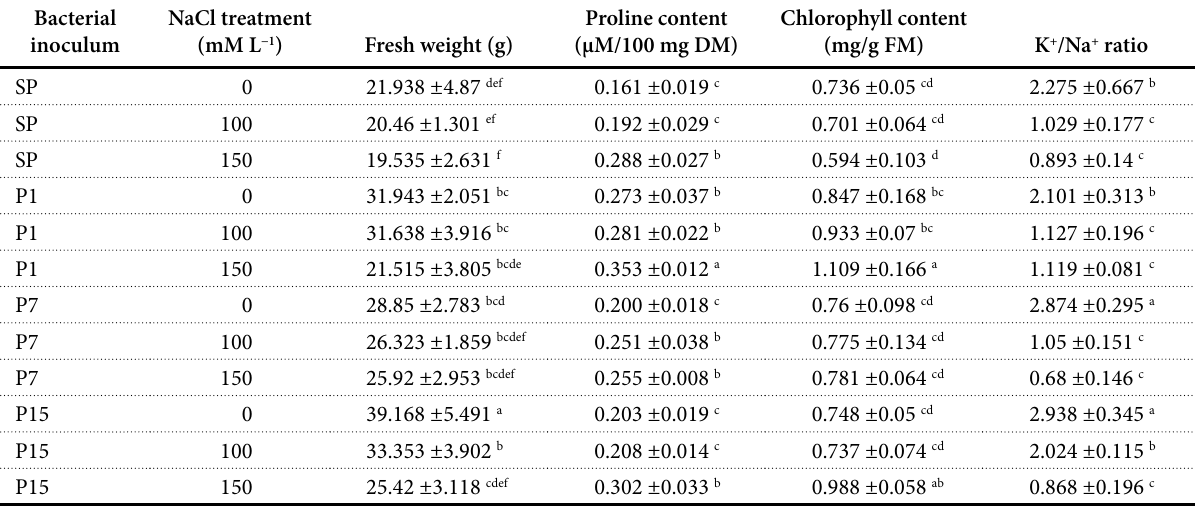
SP – treatment without bacterial inoculation; DM – dry matter; FM – fresh matter. The SP treatment was not inoculated. Results are presented as the mean ± standard deviation; lowercase letters denote homogeneous